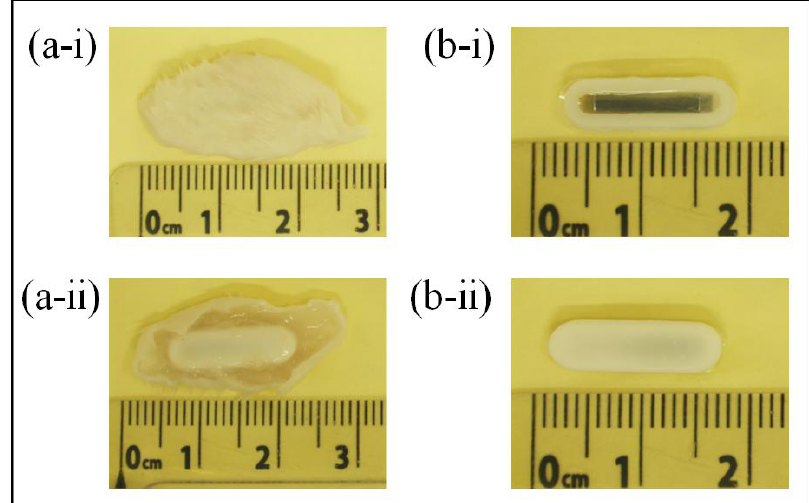
Figure 13. Photographs showing the ( a ) sensor embedded in skin-tissue structure and ( b ) 28-day implanted sensor after skin removal. ‘ i ’ and ‘ ii ’ indicate the front and back of the surface of the sensor